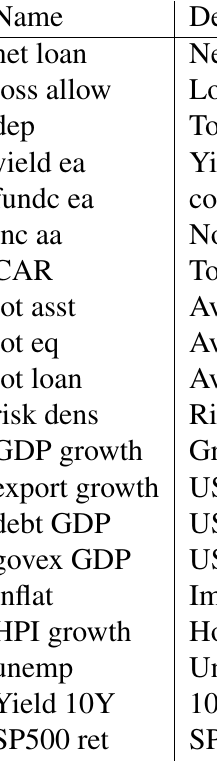
Table 1: Variables used in the experimental phase and the category they belong to: the label FIN denotes financial indicators and MAC denotes macro-economic